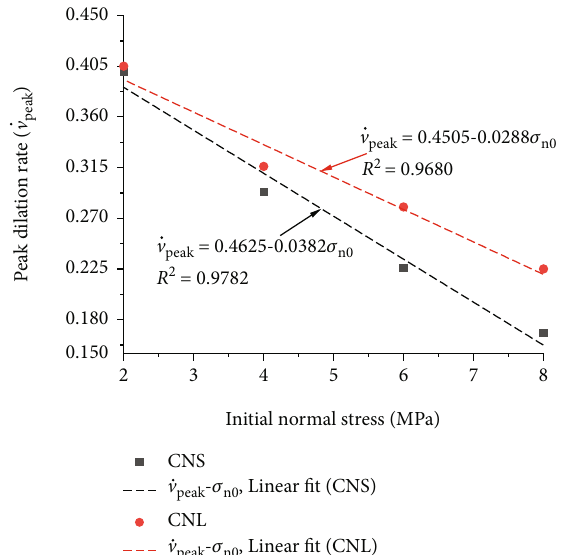
Figure 12: Variation of peak shear stress with normal stress.